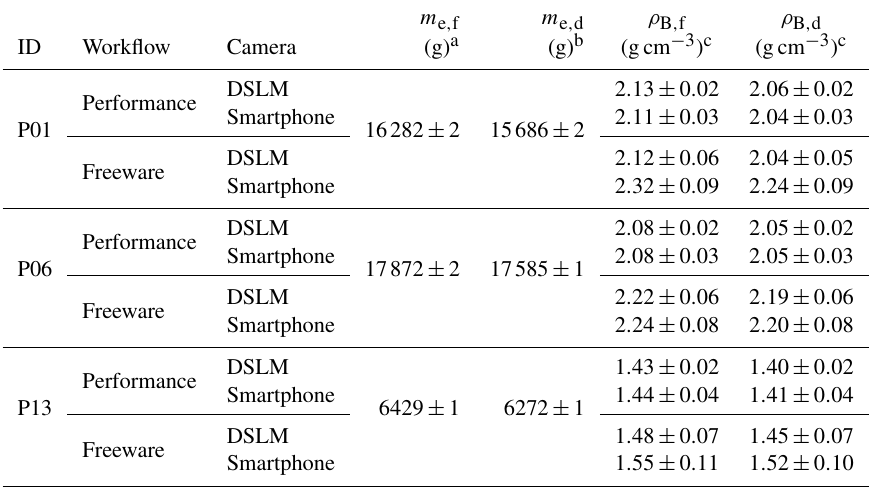
Table B2. Comparison of field-state ( ρ B , f ) and dry bulk densities ( ρ B , d ) for the different workflows and cameras tested.